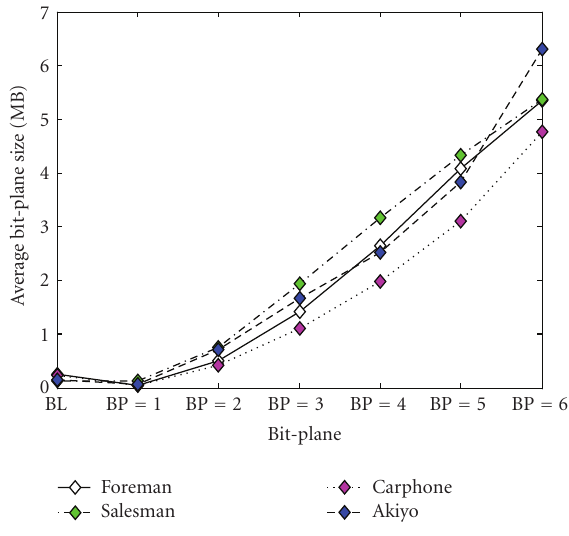
Figure 4: Average size of the bit-planes for the various QCIF refer- ence